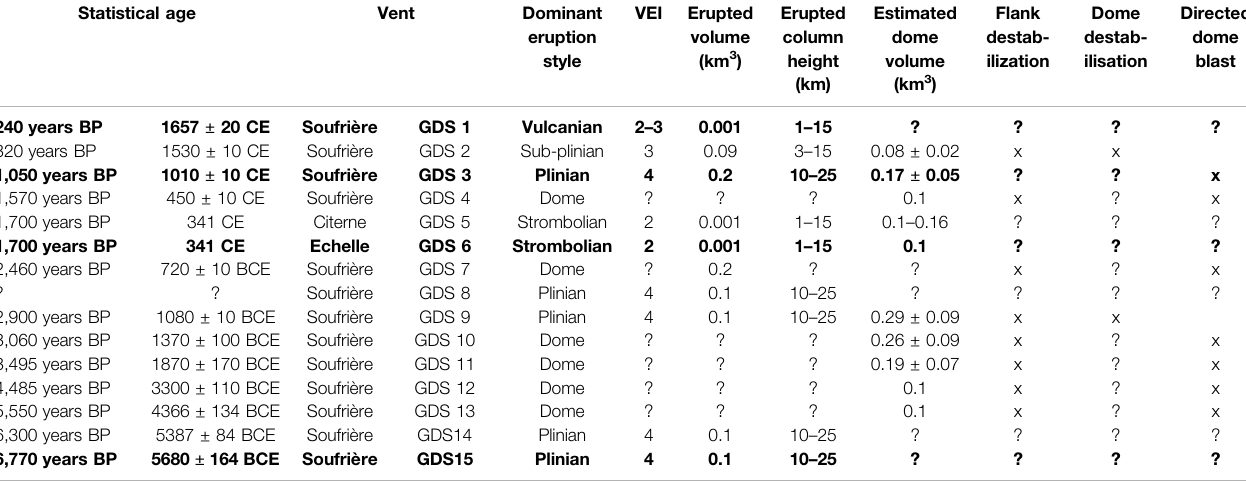
TABLE1| SynthesisoftheeruptionrecordforLaSoufrièreofGuadeloupeinthelast9,160yearsadaptedfromKomorowskietal.(2005),Legendre(2012),Komorowskietal. (2012), Komorowski et al. (2013) where more details on carbon dating is available. Statistical